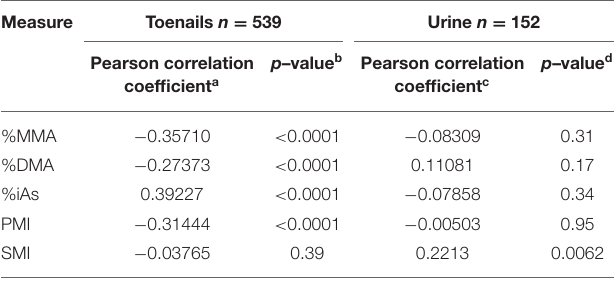
TABLE 7 | ANCOVA models using matched toenail ( n = 140) and urine ( n = 140) samples to test the relative statistic power of toenail and urine samples to capture altered arsenic methylation in prostate cancer